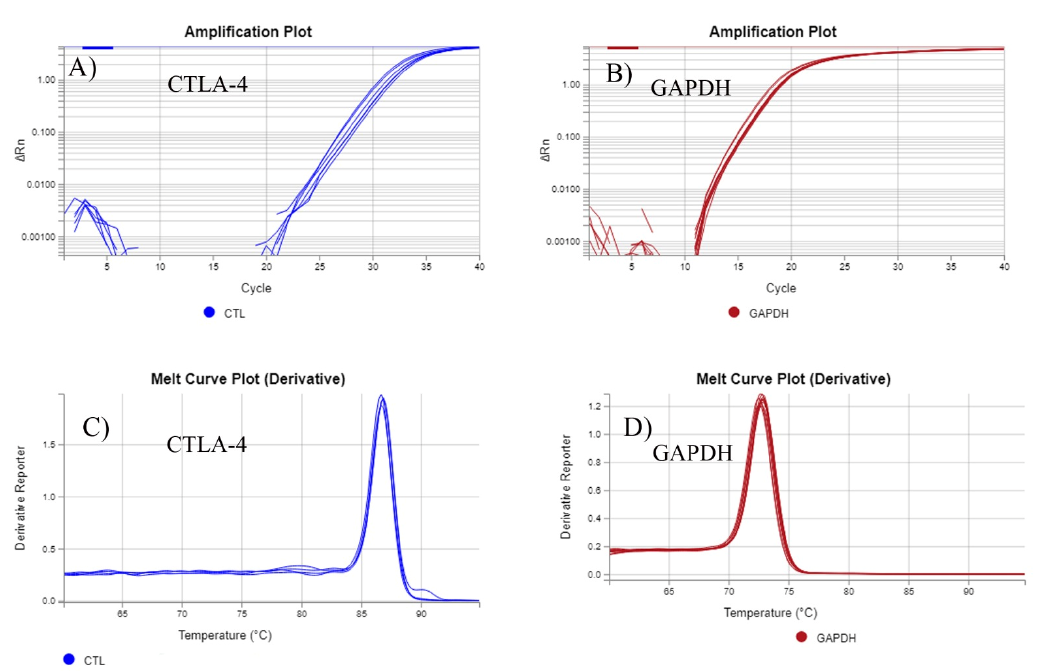
Figure 1. Amplification curves ( A , B ) and melting curves ( C , D ) for the target CTLA-4 gene and the reference GAPDH gene.